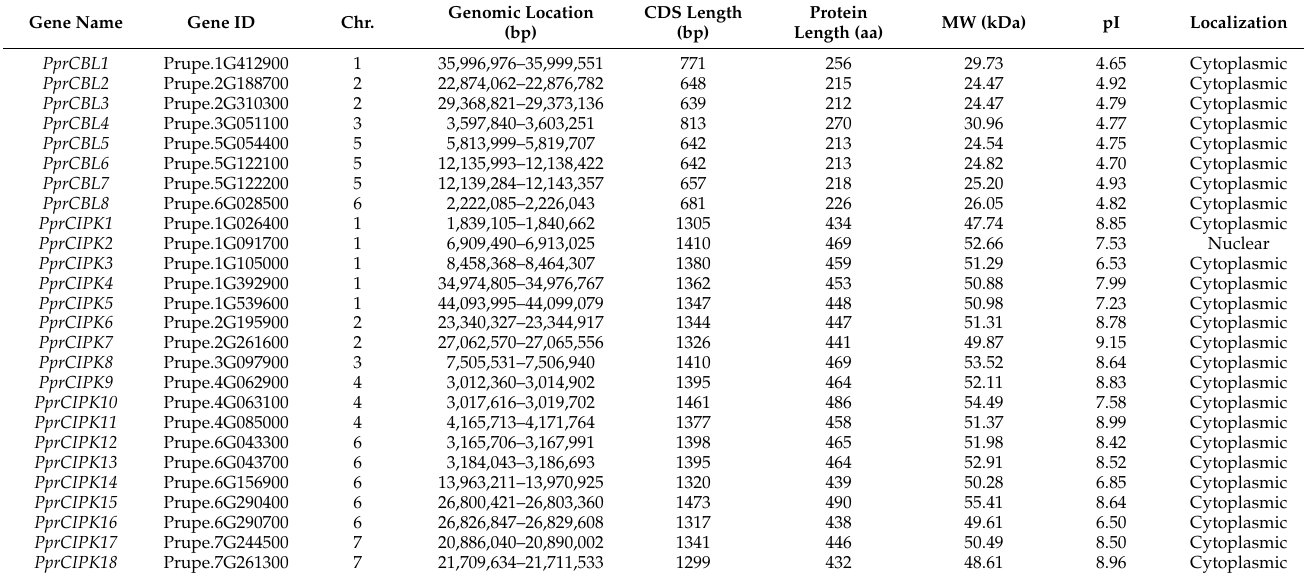
Table 1. Characteristics of PprCBL and PprCIPK genes and the encoded